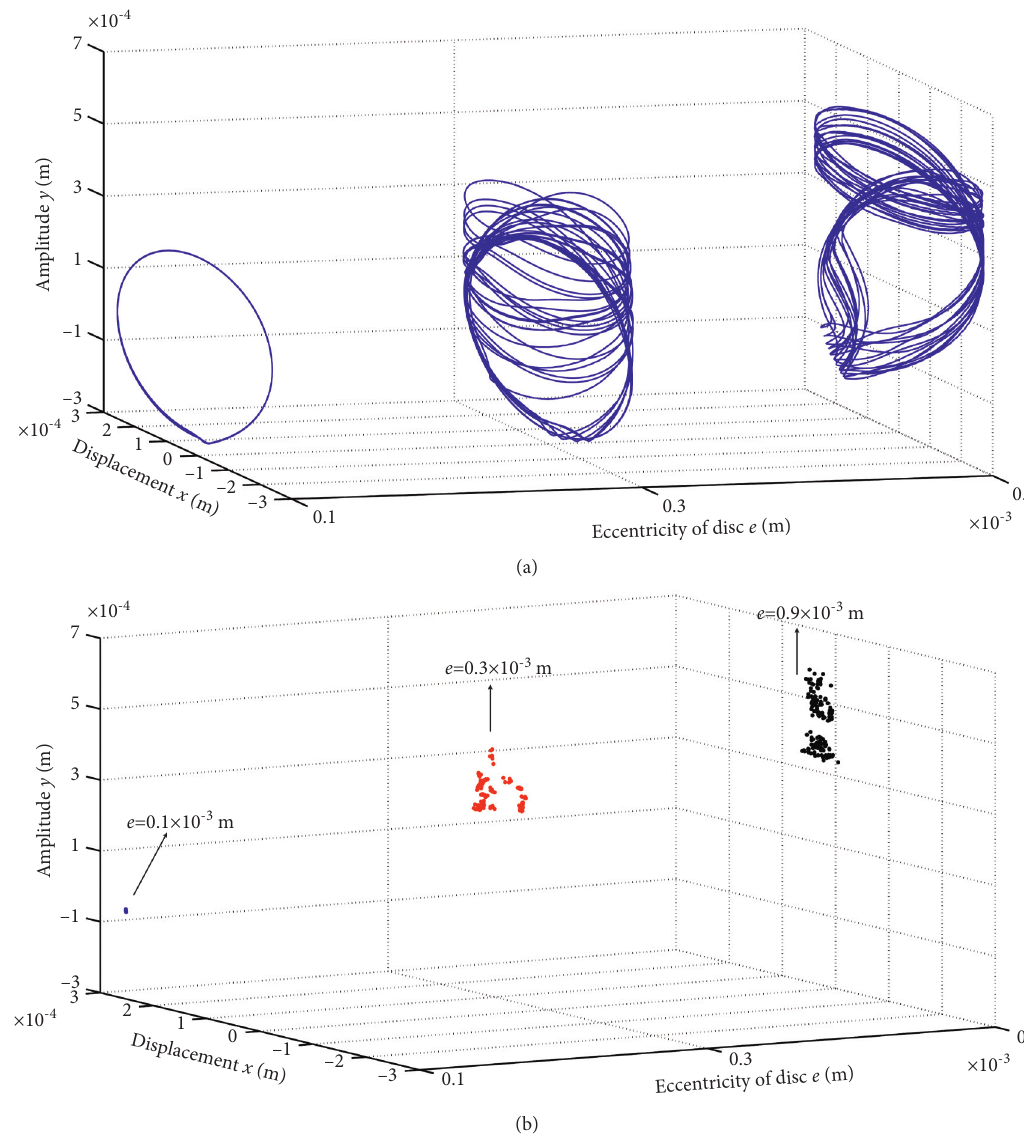
Figure 11: Rotor orbits and Poincar´e maps of the right journal with the change of the unbalance of two discs. (a) Rotor orbits. (b) Poincar´e